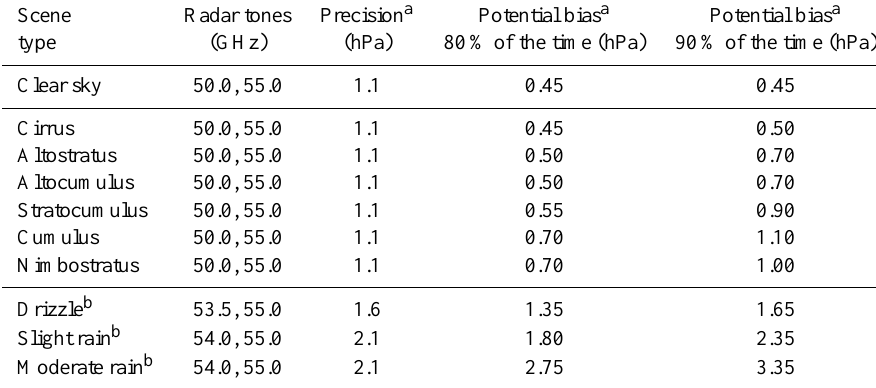
Figure 7. Precision and potential biases for the nimbostratus case shown in Fig. 6 using all the possible combinations between 50 and 55GHz every 0.5GHz. The hydrometeor bias is the root-mean-square sum of the errors labeled IWC, IWC PSD1, IWC PSD2, LWC, LWC PSD, Rain, Rain PSD1, Rain PSD2, Snow, and Snow PSD in Fig. 6. Table 2. “Optimum” radar